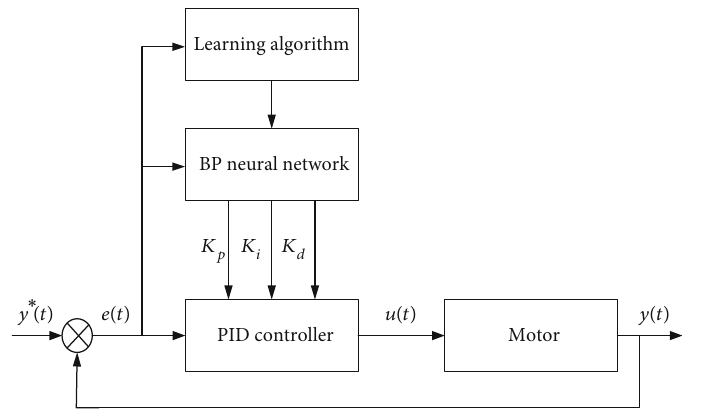
Figure 9: The control system of BP neural network PID controller.